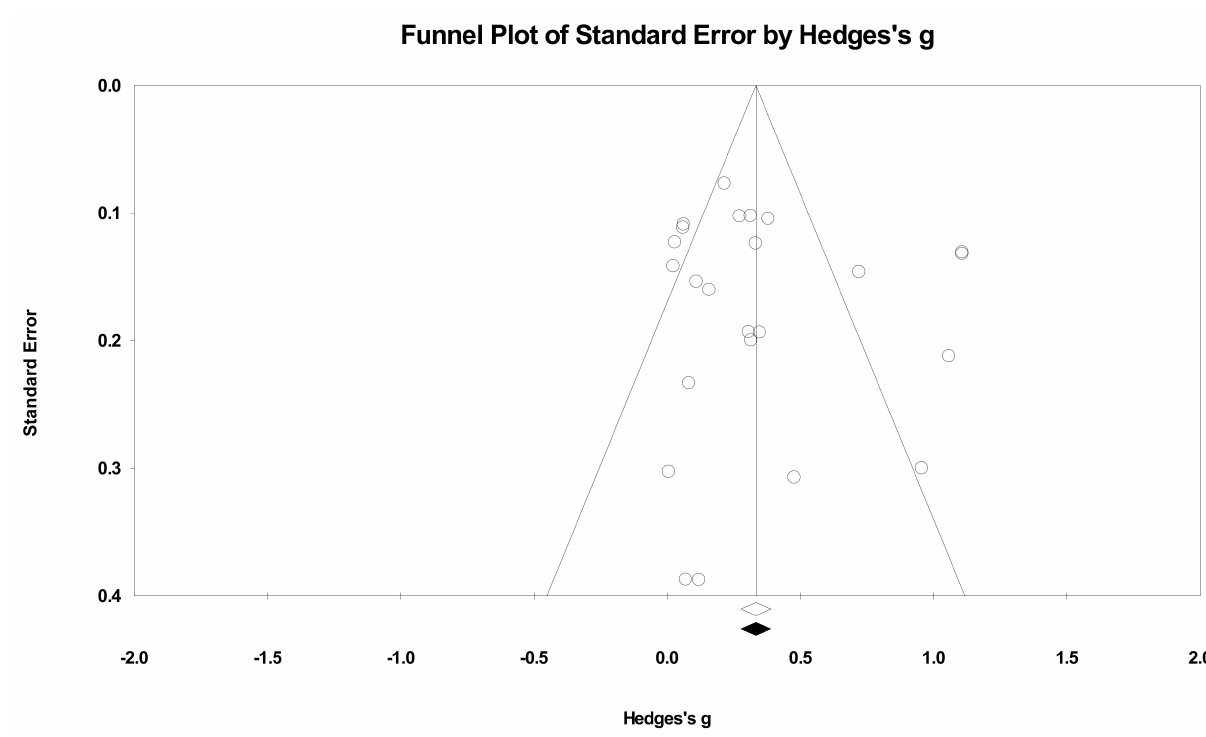
Figure 3. Funnel plot of diastolic blood pressure by Hedges’ g (plot observed and imputed), random effects model. Notes. Summary effect size ( ◇ ); Summary effect size of imputed studies ( ◆ ); Individual studies ( ○ ).